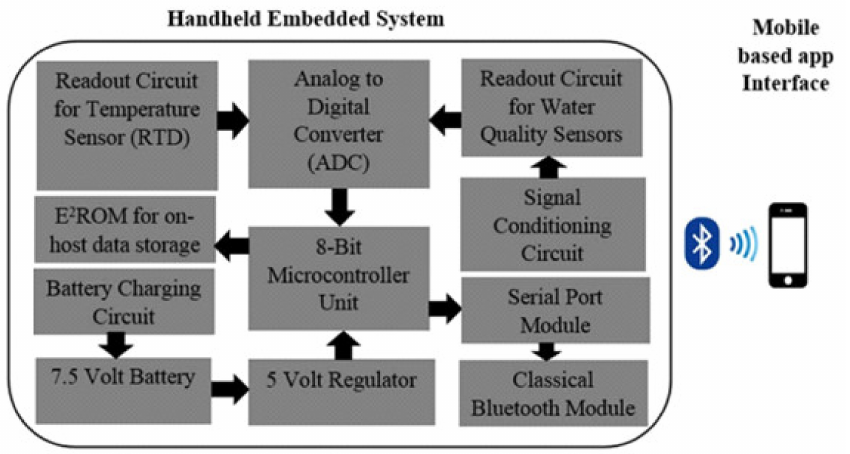
Figure 10. Block diagram of the system proposed in